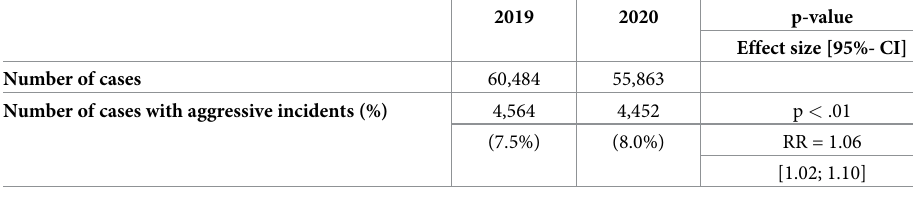
Table 4. Cases and cases with aggressive incidents in 2020 compared to